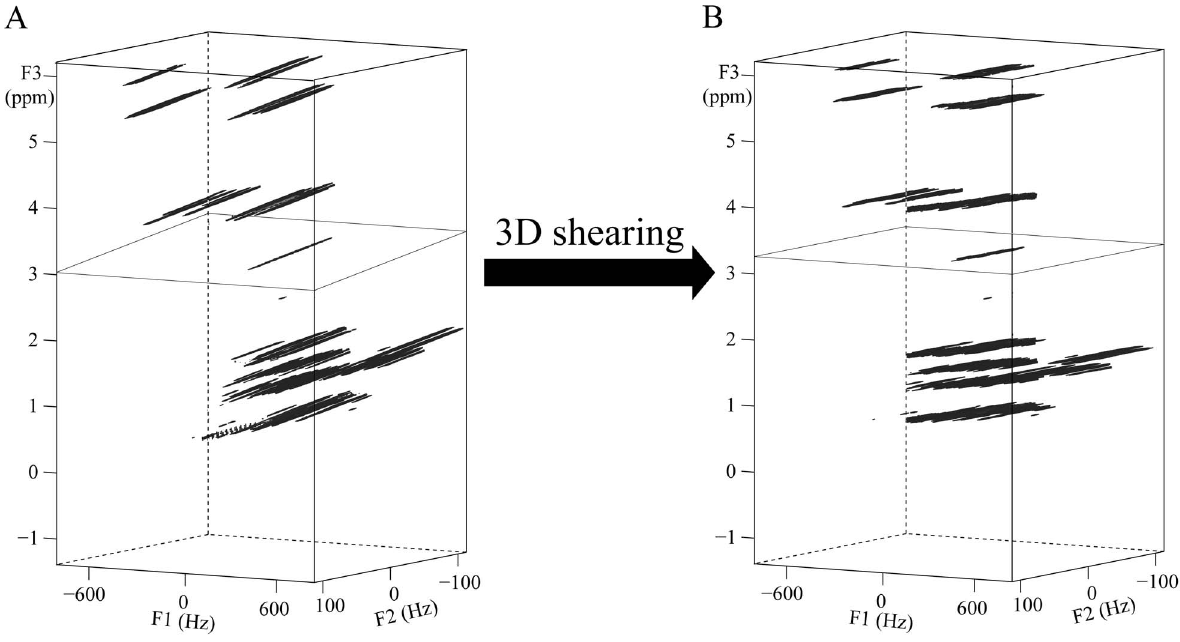
Figure 3. The shearing process for 3D DDF-SECSY data of butyl methacrylate in DMSO: (A) original 3D spectrum before shearing and (B) processed 3D spectrum after shearing. The given F1–F2 plane where a singlet signal at 3.1 ppm lies is selected to show the rotation of signal streaks by shearing process. Before shearing, the signal streaks are parallel to the F2–F3 plane and perpendicular to the F1 dimension. After shearing process, the signal streaks only stretch along F2 dimension and are perpendicular to the F1–F3 plane, resulting in high-resolution SECSY information on the F1–F3 plane.